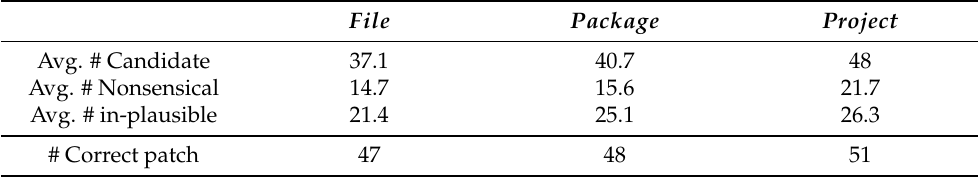
Figure 7. Distribution of ingredient pool. Table 5. Efficiency and performance changes according to the ingredient